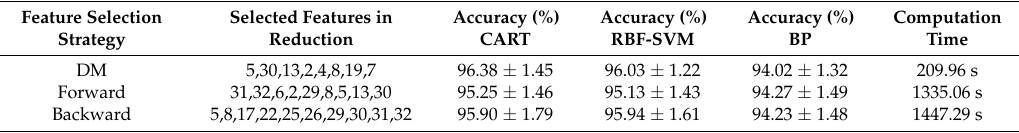
Table 5. Performance comparison of different feature selection strategies